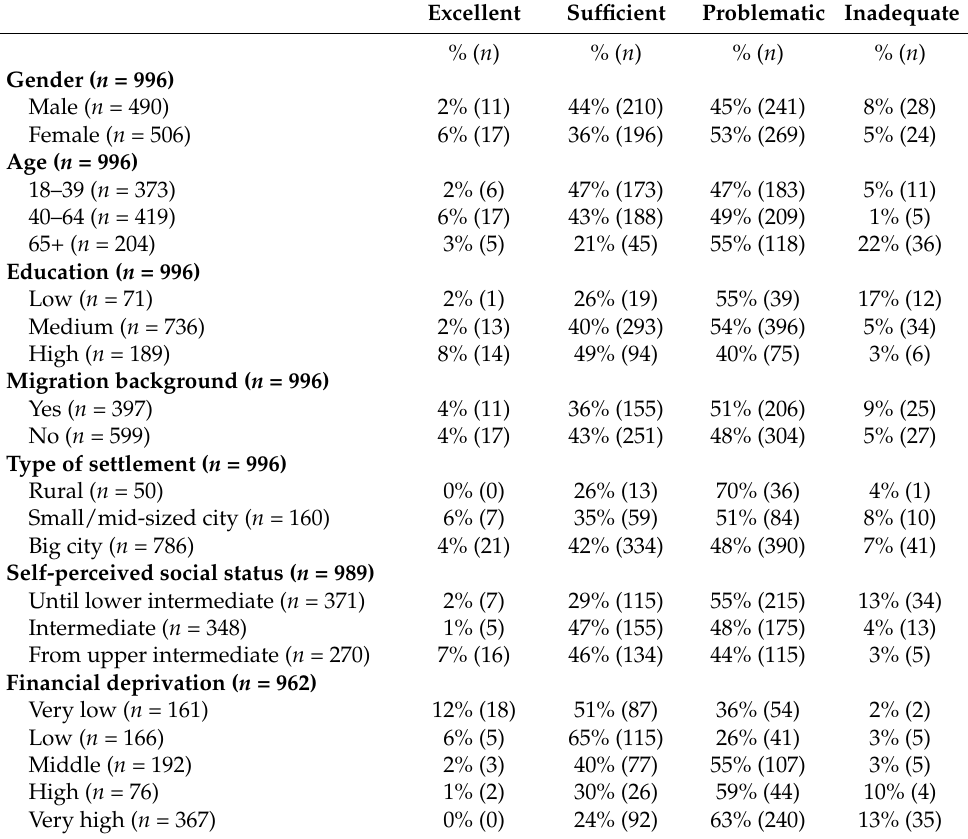
Table 2. Health literacy by sociodemographic factors. Excellent Sufficient Problematic Inadequate % ( n ) % ( n ) % ( n ) % ( n